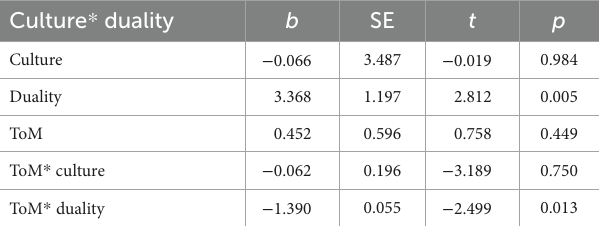
TABLE 7 Moderating role of culture and duality on the relationship between ToM and prosocial behaviour. Culture *